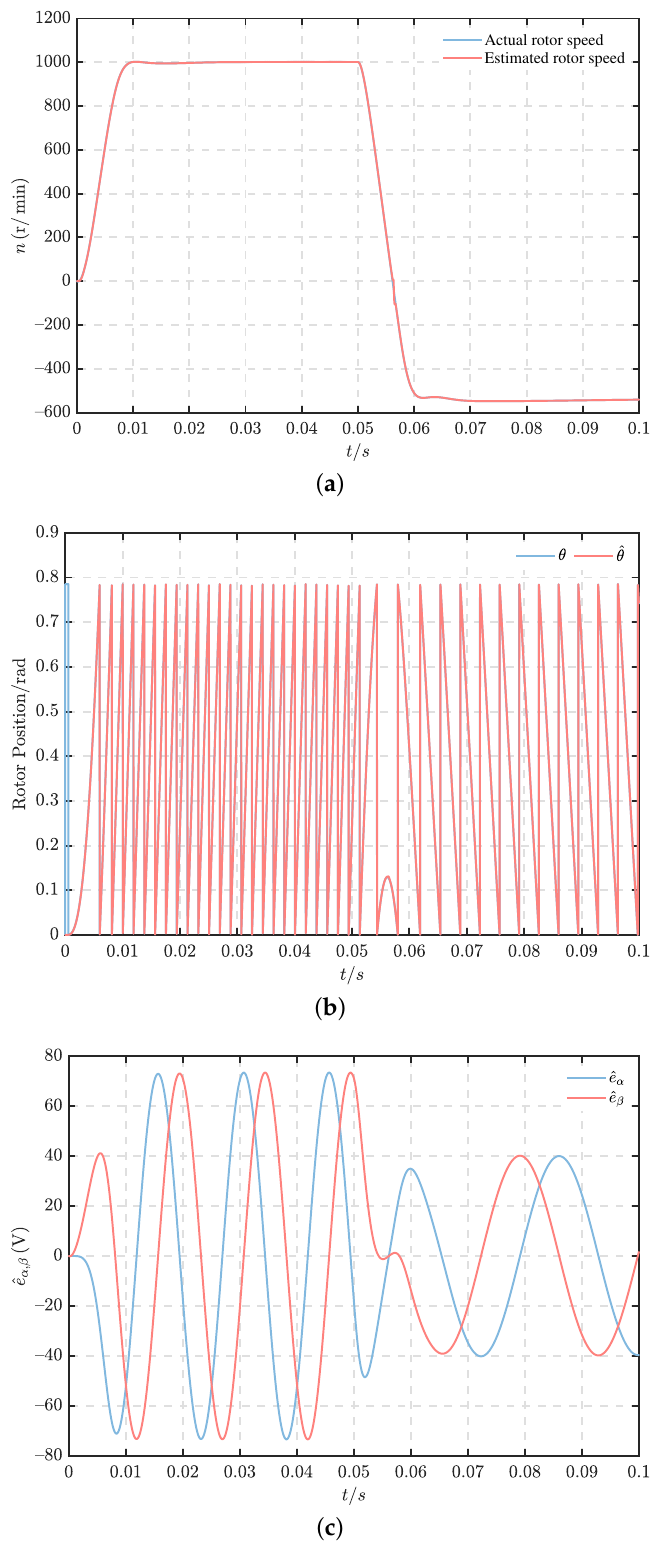
Figure 17. Responses of simulation with the improved SMO combined with feedforward PLL (forward and reverse). ( a ) Rotor speed. ( b ) Rotor position. ( c ) Estimation of the